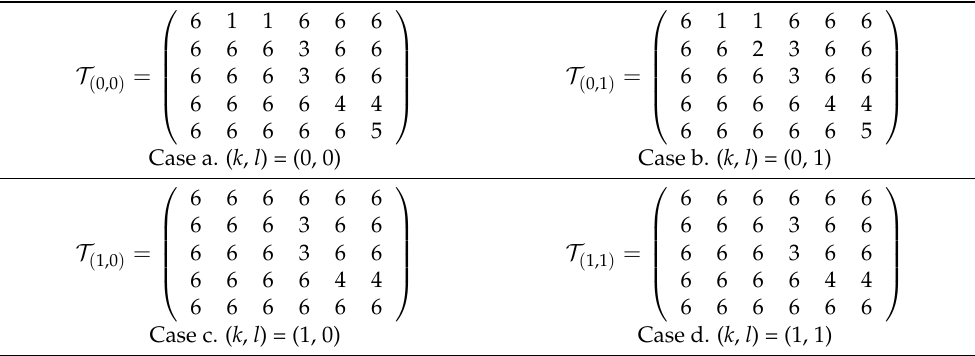
Table 3. Values for τ ( i , j , k , l ), i ∈ H , j ∈ H ∪ ( T + 1) and k , l ∈ {0,1}.